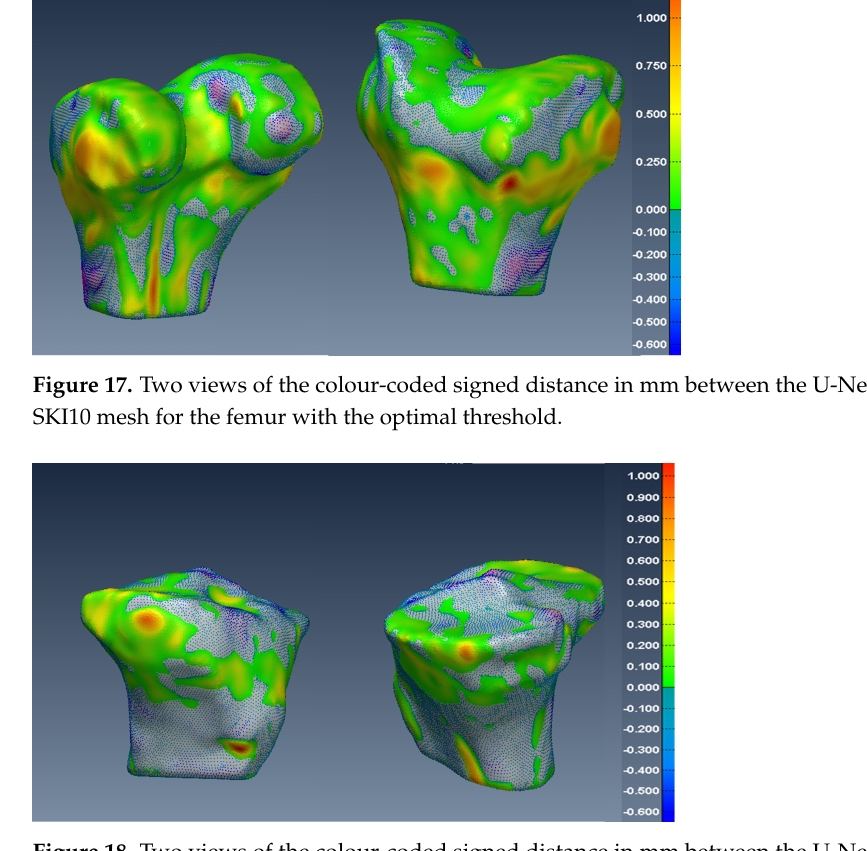
Figure 18. Two views of the colour-coded signed distance in mm between the U-Net mesh and the SKI10 mesh for the tibia with the optimal threshold.